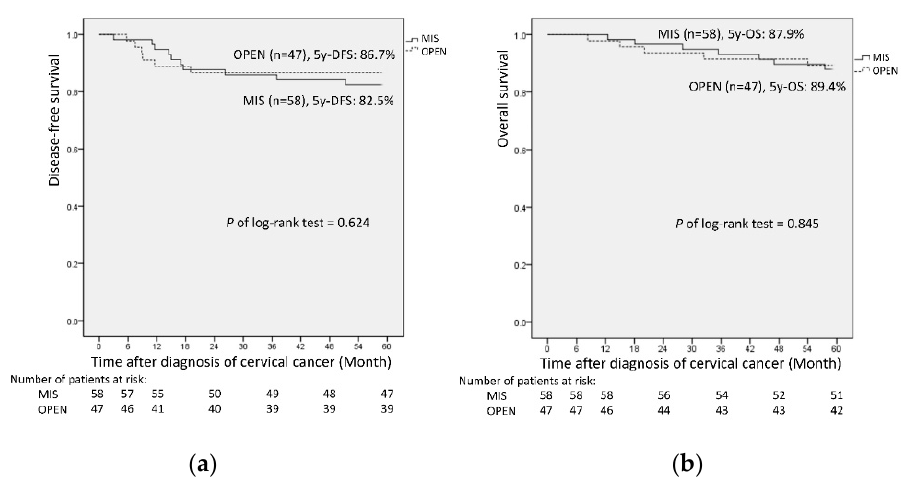
Figure 1. Oncologic outcomes of minimally invasive surgery (MIS) versus open radical hysterectomy: ( a ) 5-year disease-free survival; ( b ) 5-year overall survival.